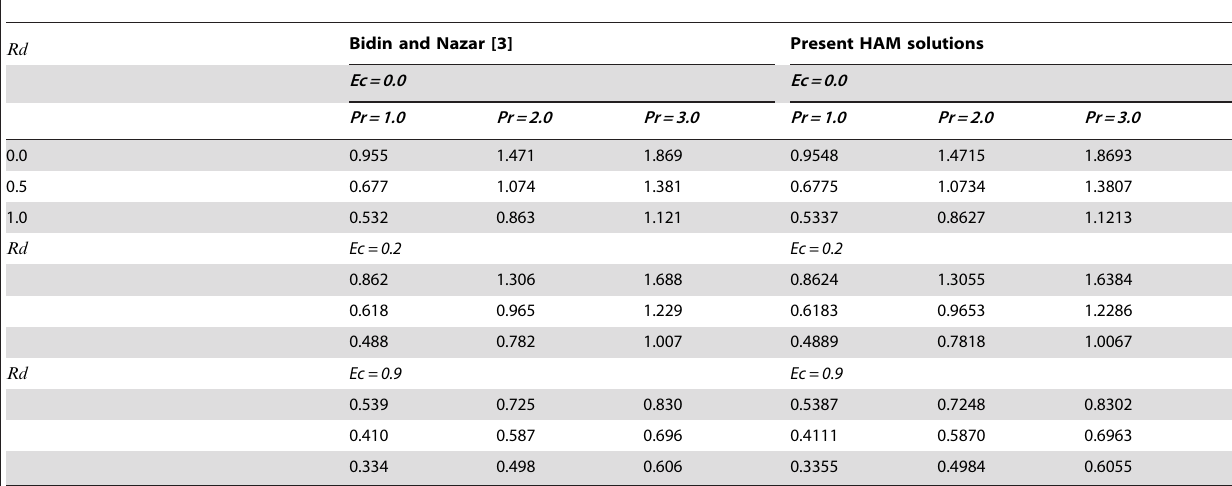
Table 3. Comparison values of { h ’ ( 0) with Bidin and Nazar [3] for different values of Ec , Pr and Rd when b ~ 0, l 1 ~